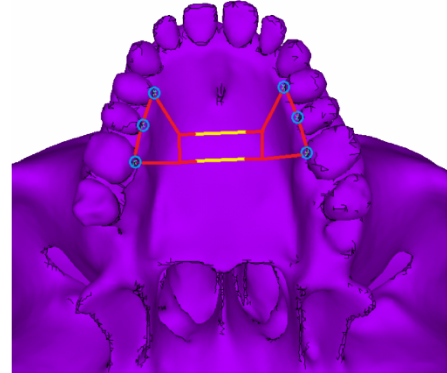
Figure 3. Schematic representation of the orthodontic appliance fixed to the teeth—tooth borne type. The module expanded by 0.5 mm is marked in yellow. Fixing onto the teeth of the facial skeleton is marked with blue markings.